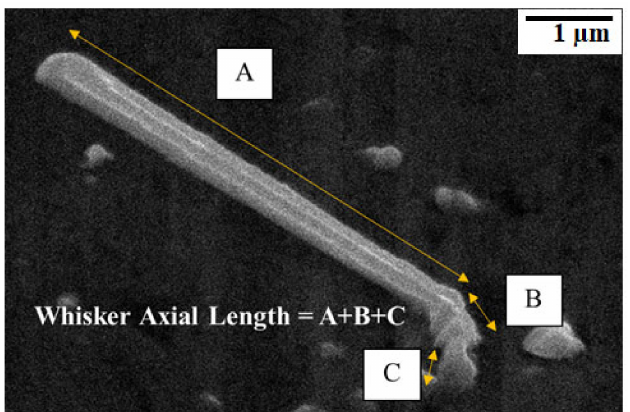
Figure 3. A method to calculate total axial Sn whisker length by adding all straight section of Sn whisker based on the JEDEC whisker